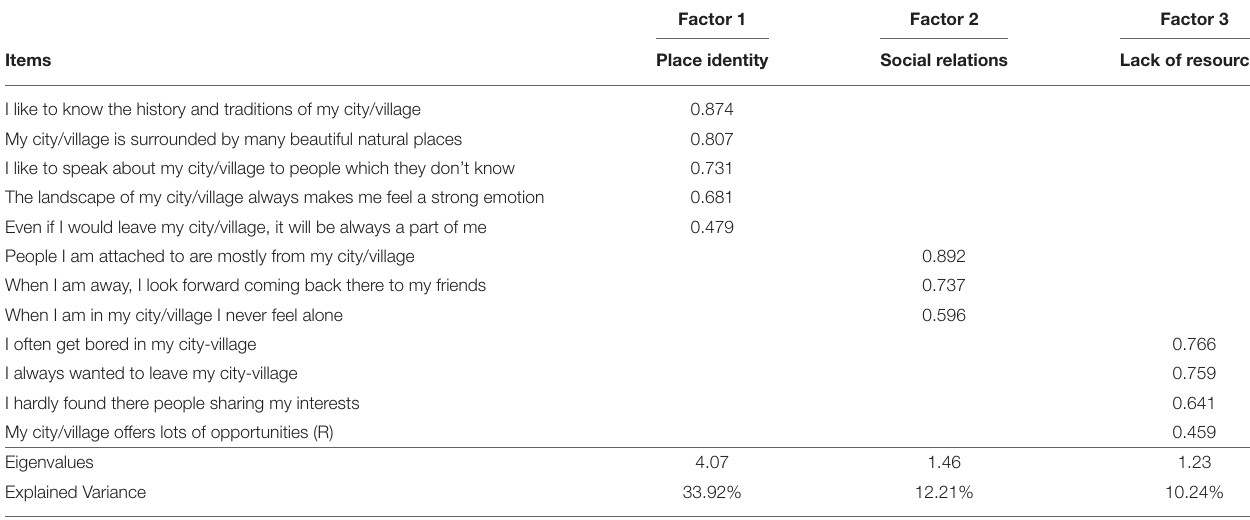
TABLE 1 | Factor analysis for the place attachment